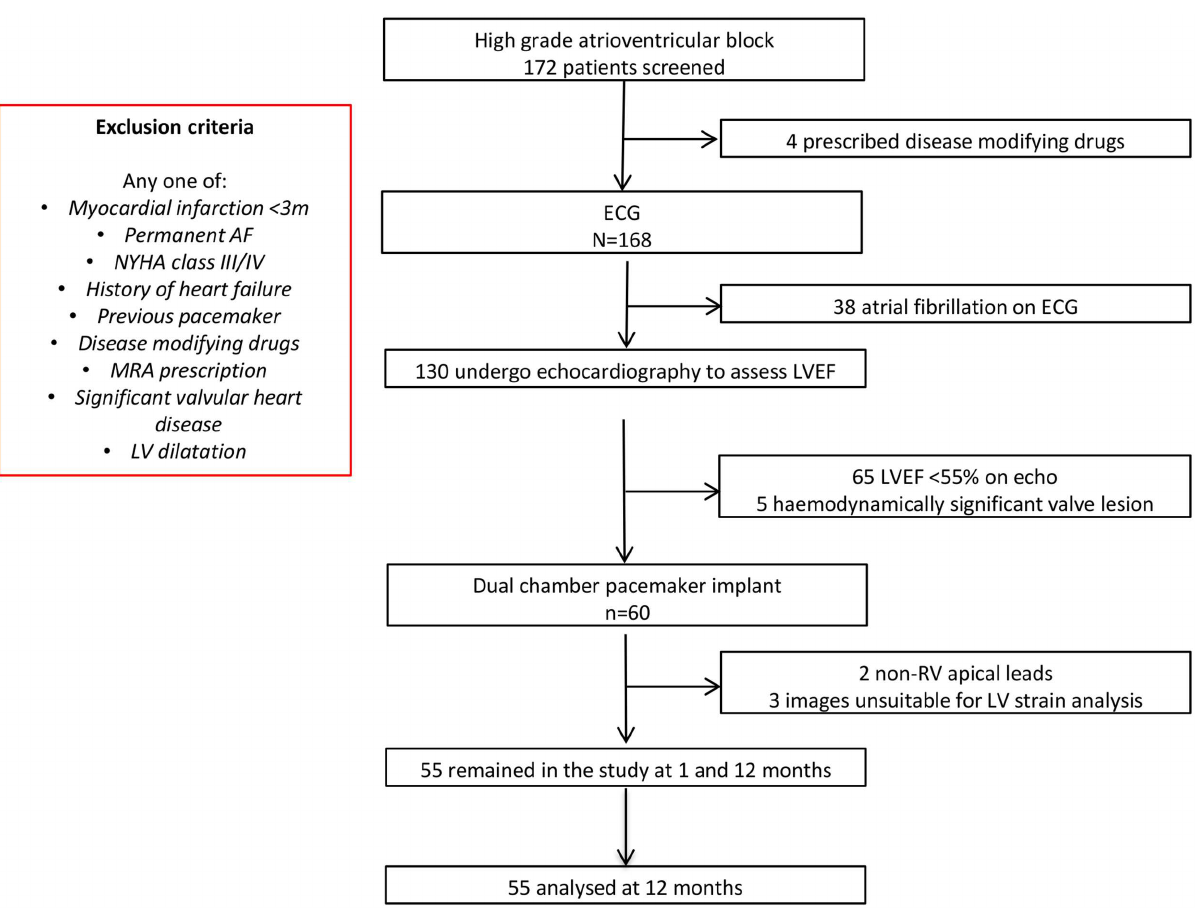
Fig 1. Patient distribution through the study at 12 months. Algorithmshowingtotal number of cases consideredfor recruitment and the reasons for exclusion,leadingto selectionof the final 55 patients.